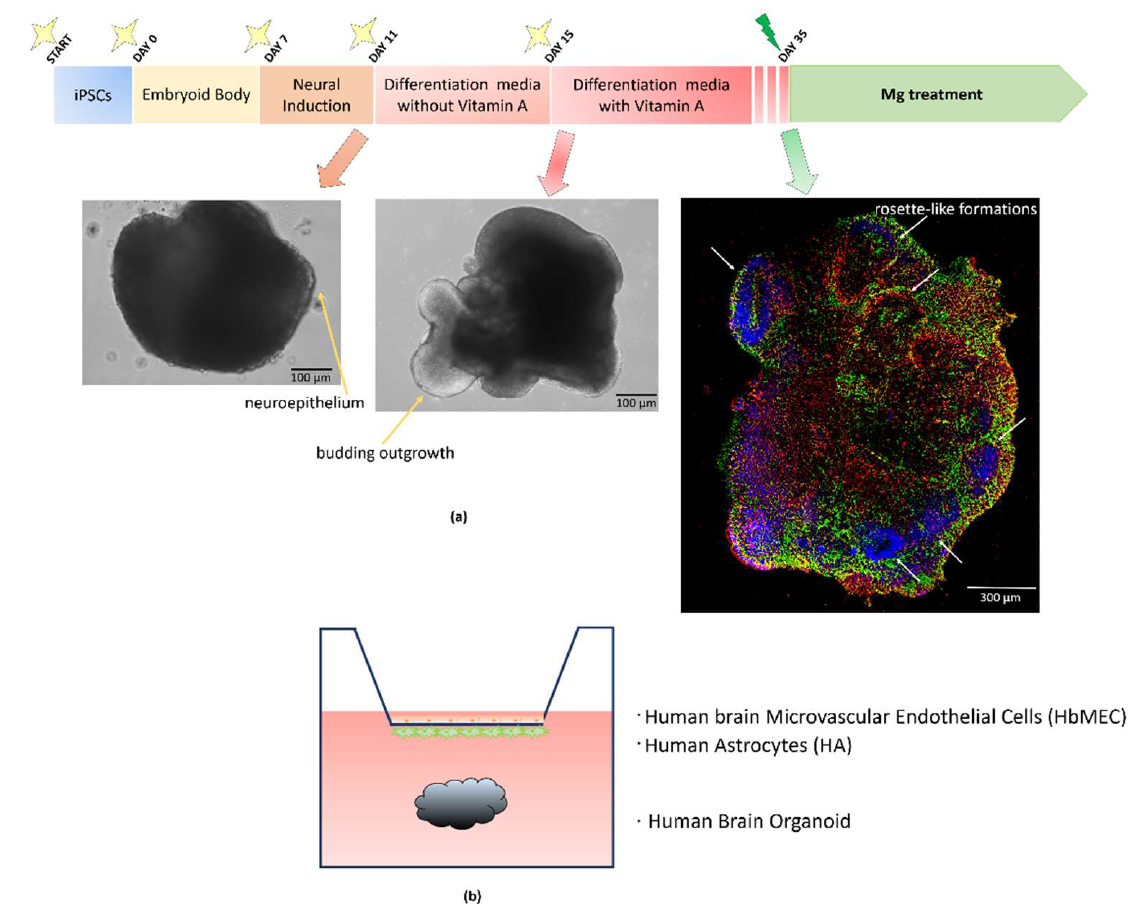
Figure 1. Graphical representation of the experimental model: ( a ) The timeline of human brain organoid generation is shown. Representative brain organoid with neuroectoderm (yellow arrow) and with budding outgrowth (yellow arrow) are shown. Immunofluorescence staining of a brain organoid after 35 days in culture. Antibodies against GABA B -R (green) and anti-astroglial calcium-binding protein S100 β (red) were utilized. DAPI (blue) labels the nuclei. Rosette-like formations are shown (white arrows); ( b ) An illustrative scheme of the BBB/organoid co-culture is shown.